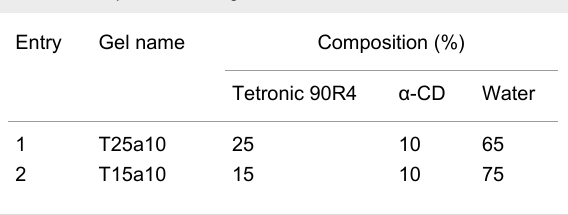
Table 1: Composition of the gels used in this